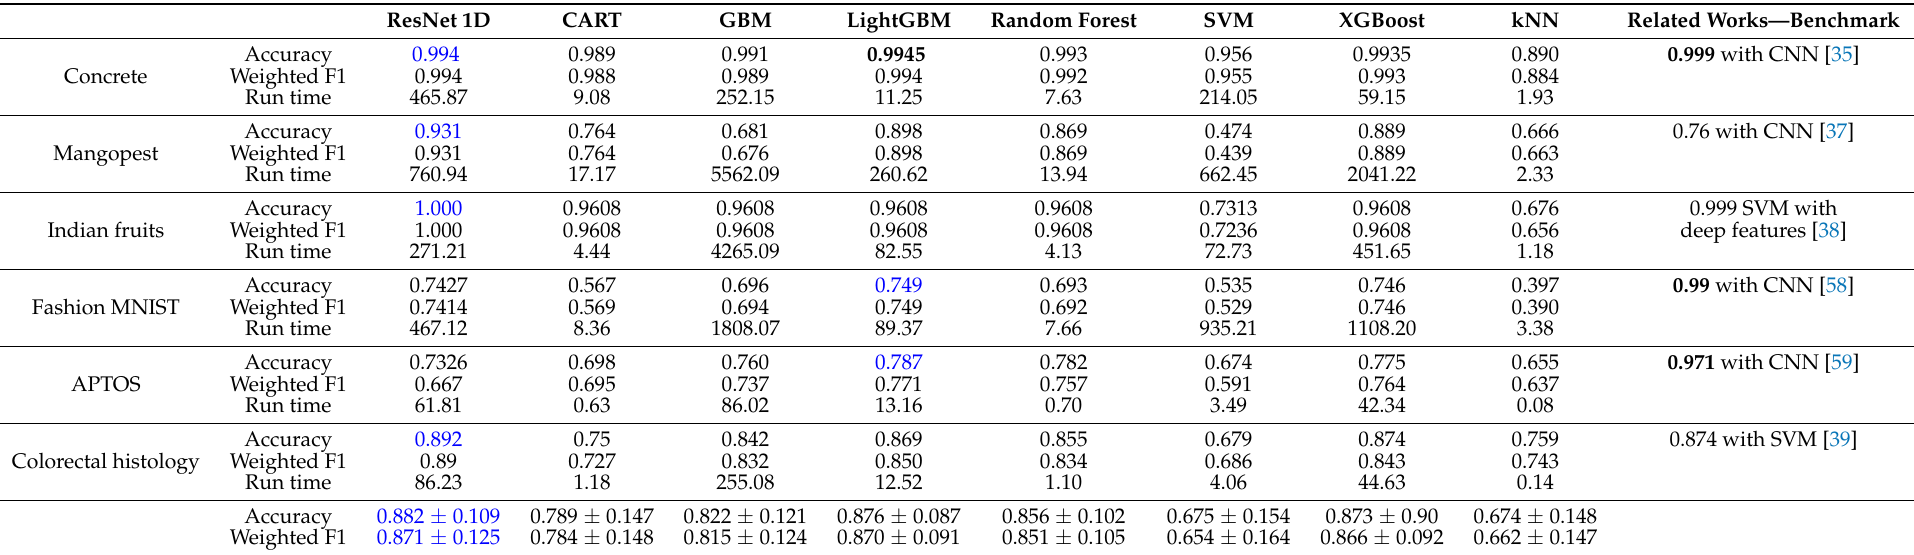
Table 3. Accuracy and weighted F1 score for each